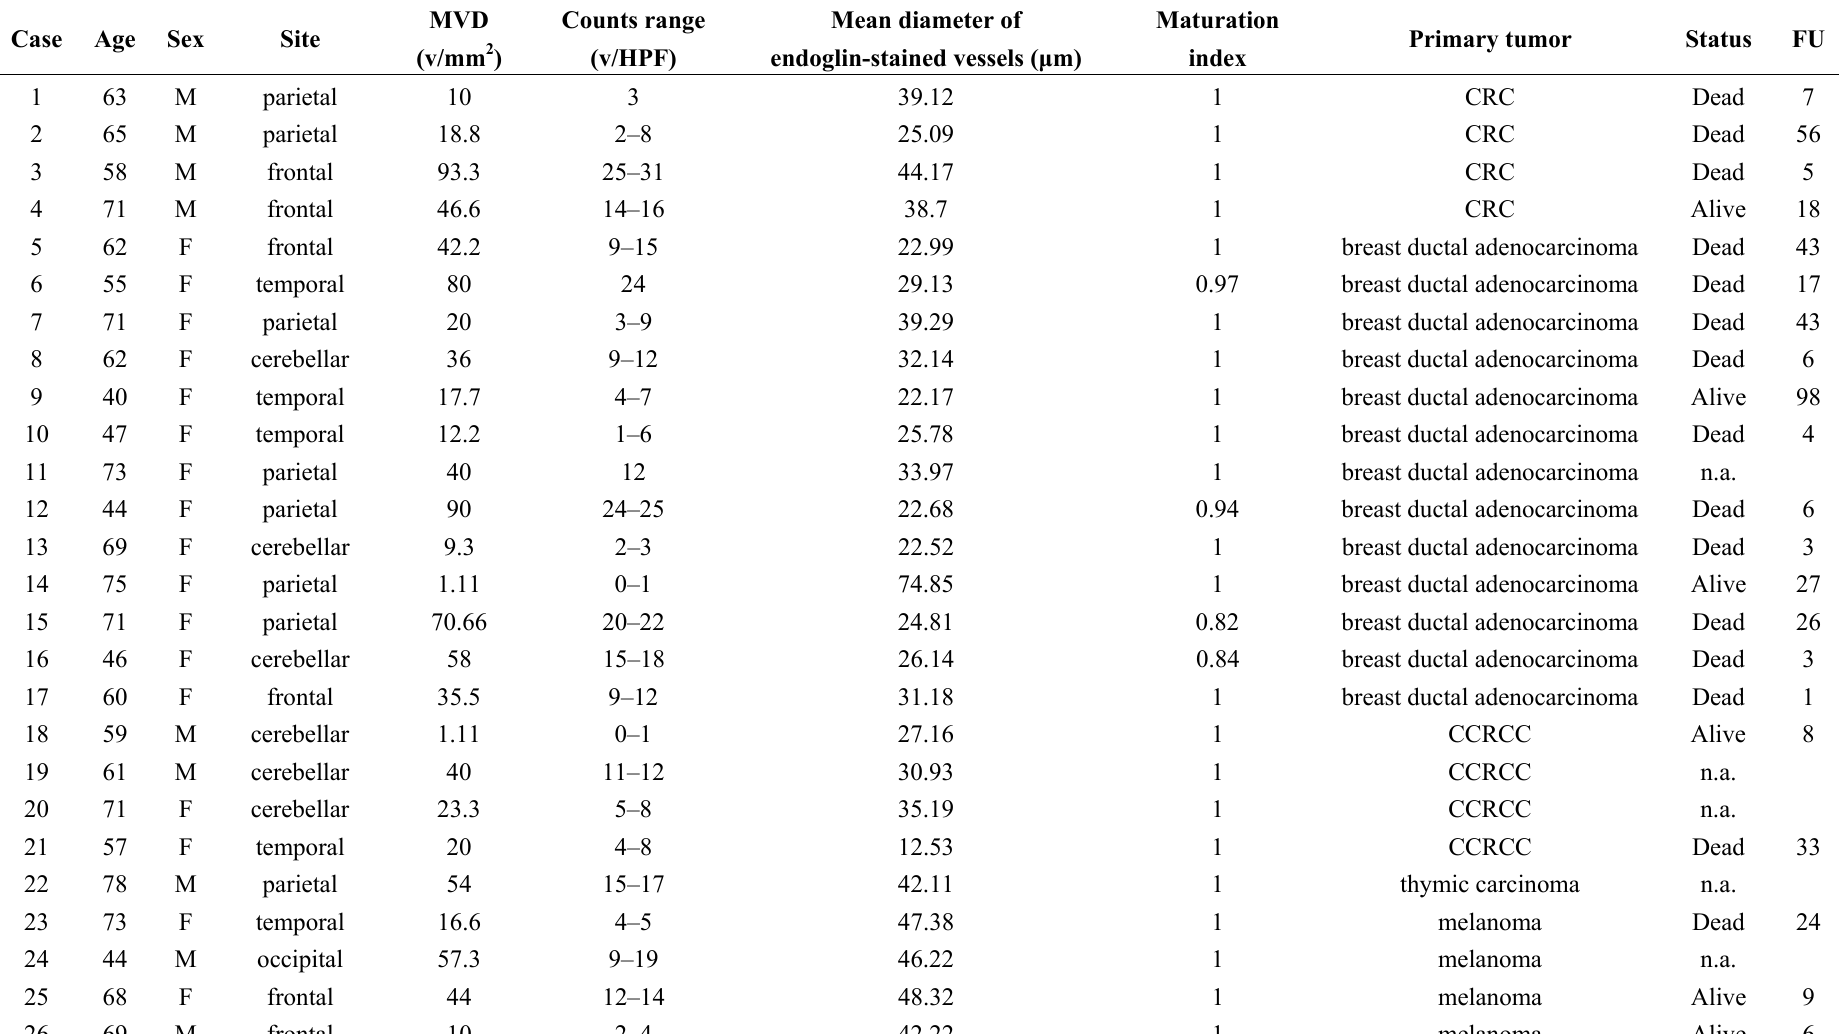
Table 1. Clinico-pathological characteristics, microvessel density (MVD) counts, vessel diameter and phenotype of the 78 brain metastases (BM) in the study. CRC, colorectal carcinoma; CCRCC, clear cell renal cell carcinoma; MPNST, malignant peripheral nerve sheath